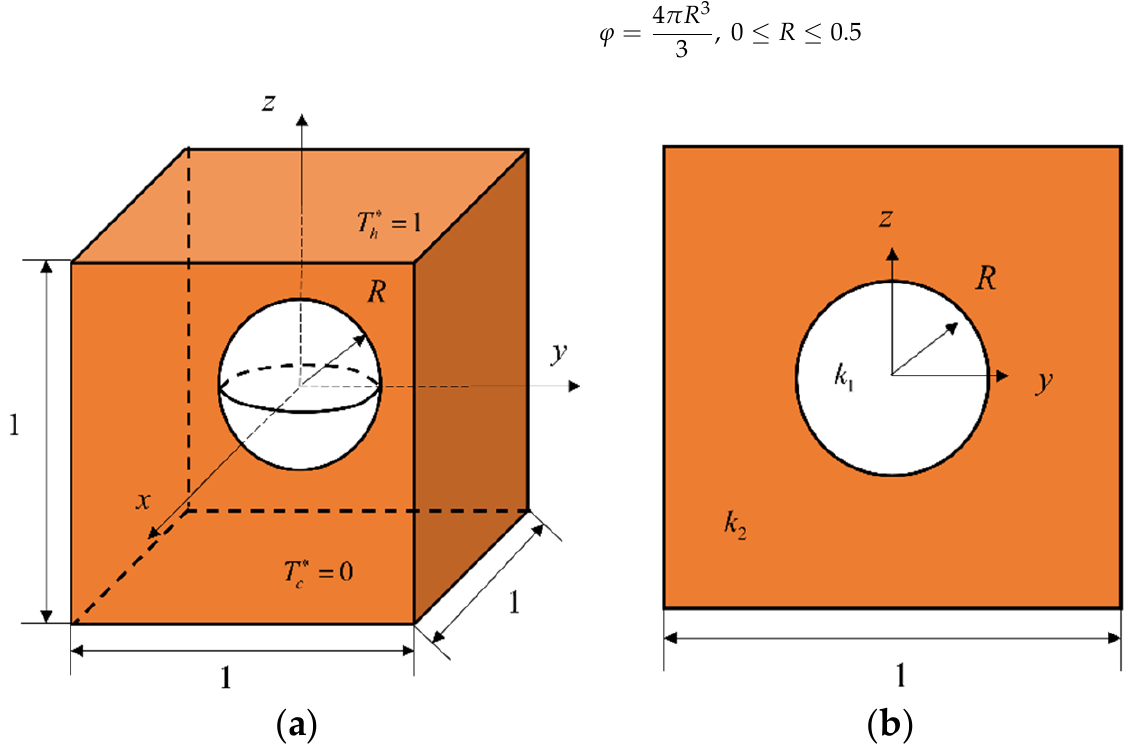
Figure 6. Schematic diagrams of validated model: ( a ) 3D, ( b ) Middle section in x direction. The mesh was generated based on the theory of the intersection of rays and